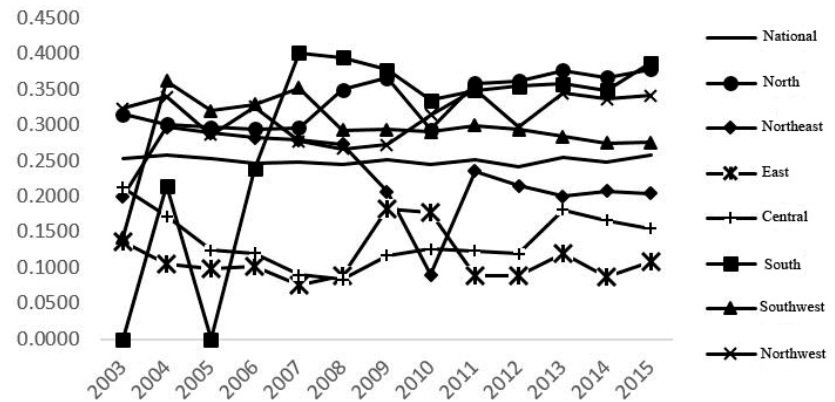
Figure 3. Variation of standard deviation of land use eco-efficiency value in China and seven regions.